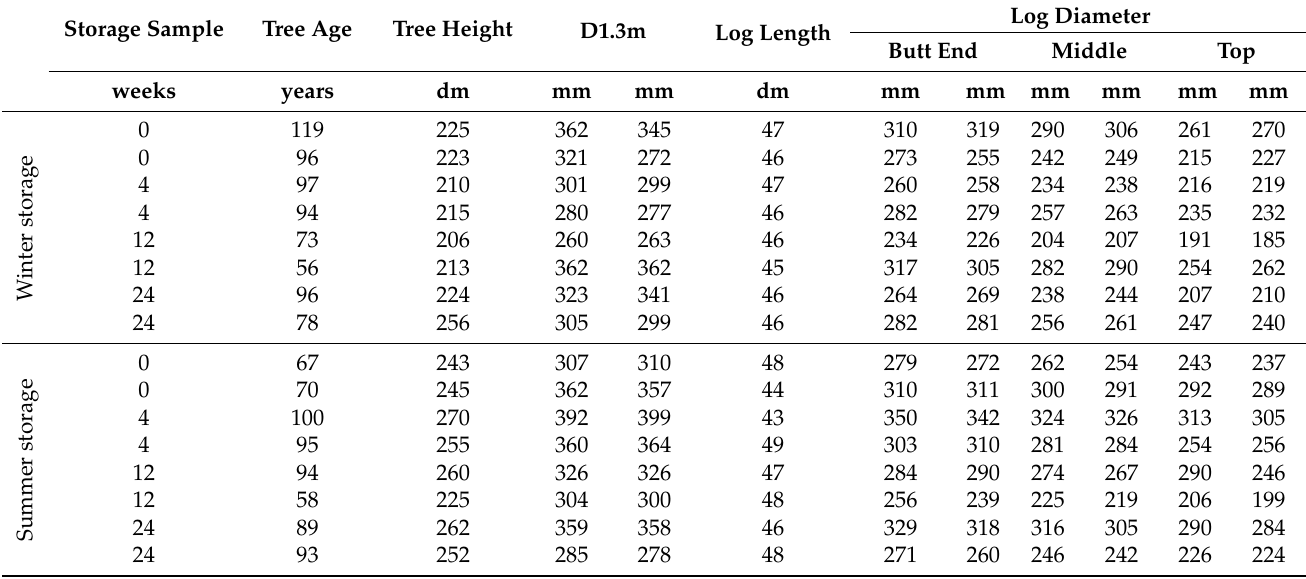
Figure 2. There was an average difference of 5.7 ◦ C during winter and summer storage; the bark in summer storage experienced a decrease in temperature starting from around 10 ◦ C, rising to 15 ◦ C after 4 weeks and ending at 0 ◦ C at 24 weeks, while the bark in winter storage experienced a constant increase in temperature from around − 5 ◦ C and ending at 15 ◦ C at 24 weeks. The average weekly amount of rain was 9.5 mm during the winter storage and 11.6 mm during the summer storage. Table 1. Measurements taken from the saw logs used for the storage studies. Two log samples were taken at each sampling